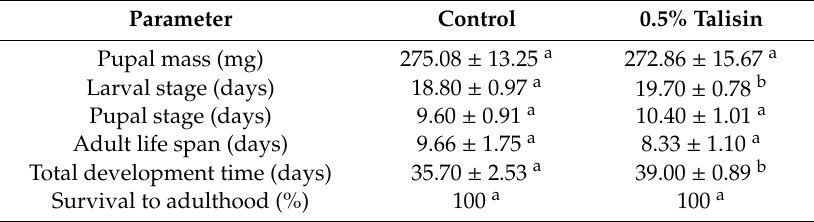
Table 1. E ff ect of dietary 0.5% Talisia esculenta reserve protein (talisin) on Spodoptera frugiperda larval development.